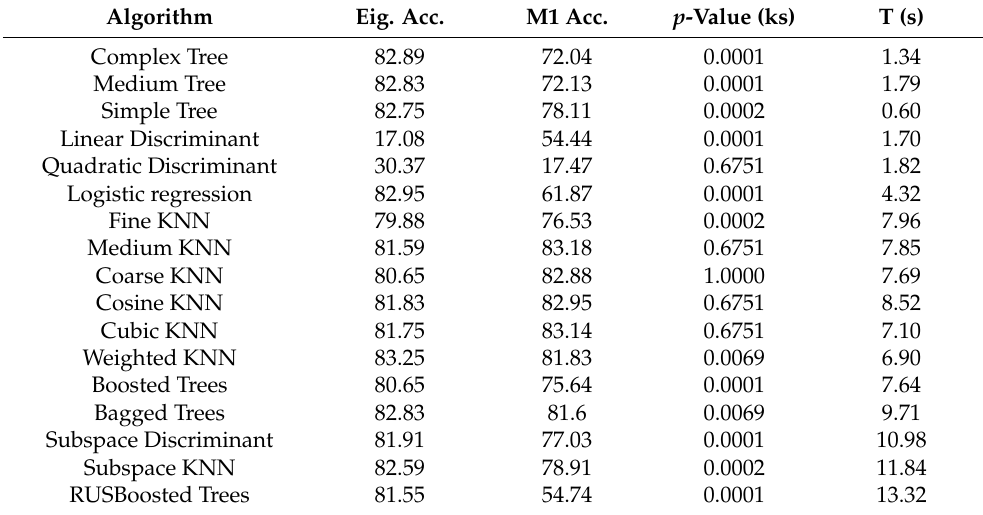
Table 2. Mean values of the accuracy for the eigenvalue approach and Model 1 as well as p -values of the Kolmogorov–Smirnov test comparing these two approaches. T refers to the average computational time required to train the